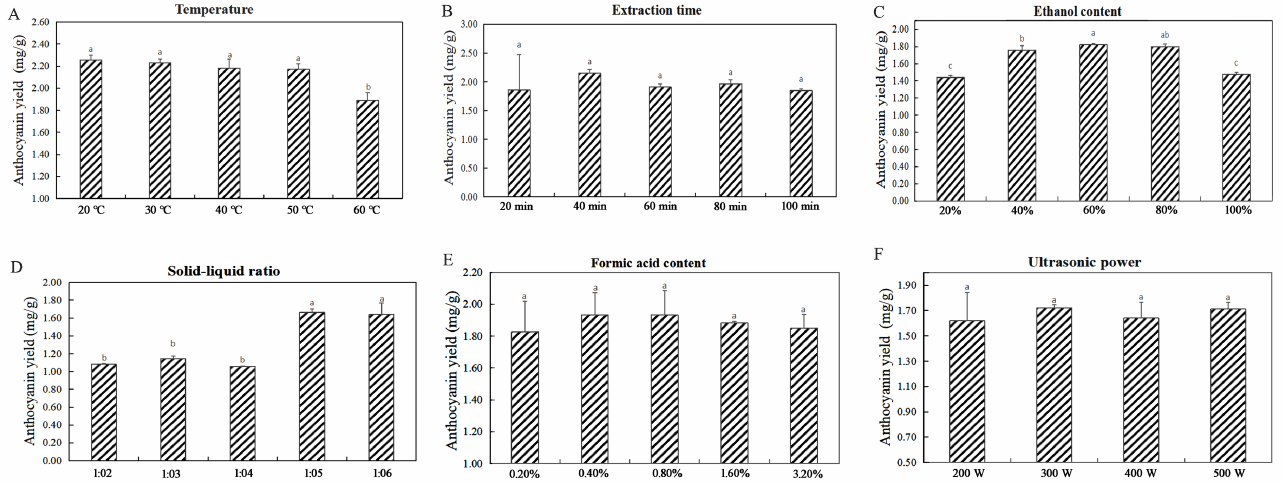
Figure 2. The influence of six single factors on anthocyanin extraction was tested. ( A ): Extraction temperature; ( B ): extraction time; ( C ): ethanol content; ( D ): solid–liquid ratio; ( E ): formic acid content; ( F ): ultrasonic